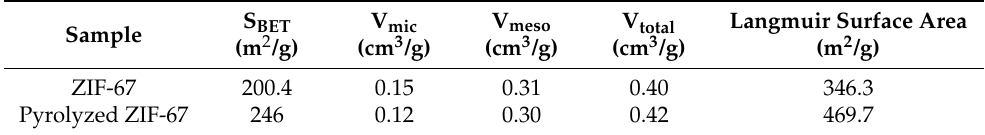
Table 3. Textural parametric quantities of MOFs ZIF-67 and pyrolyzed ZIF-67.